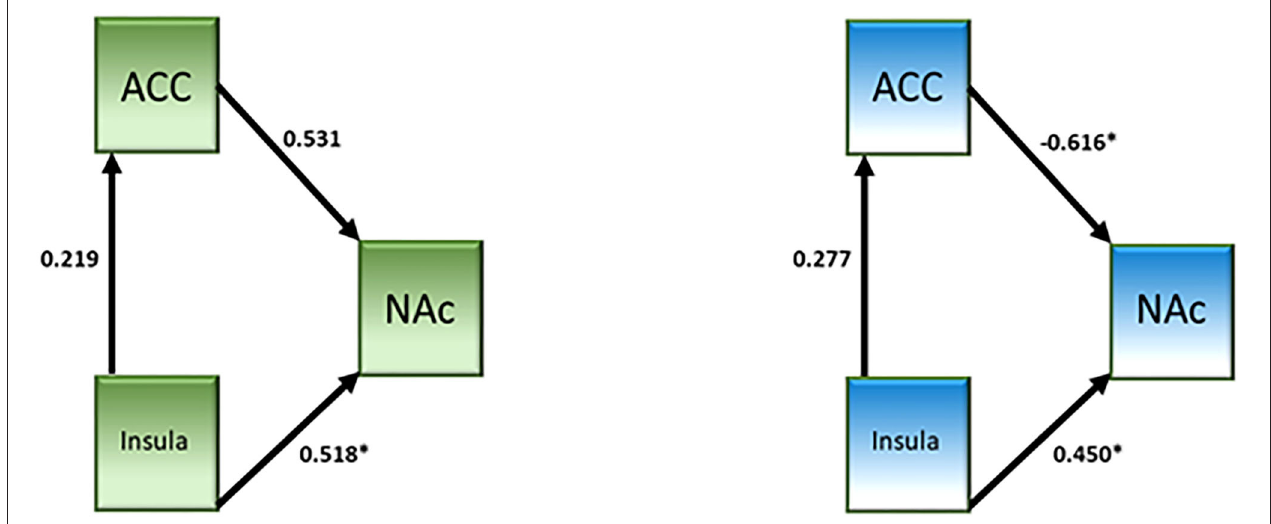
FIGURE 3 | Effective connectivity network analysis results from the cannabis use group (left, green) and the control group (right,